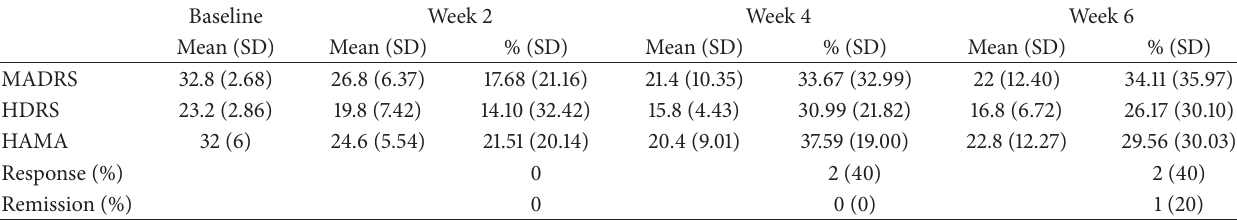
Table 2: Changes in depressive symptoms throughout the study (pilot phase).